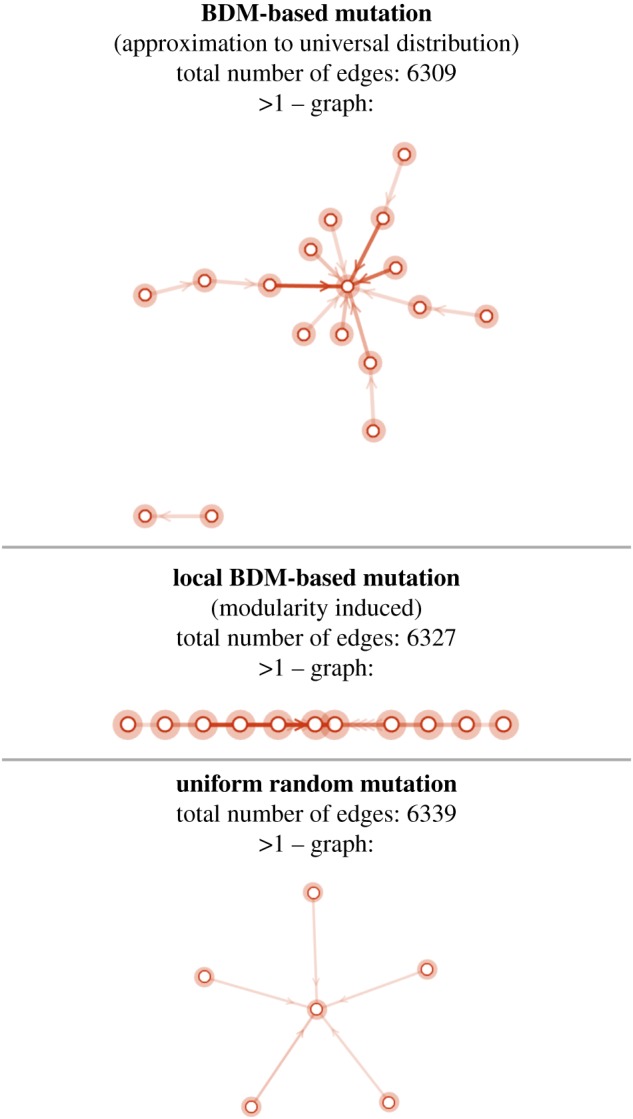
Evolutionary convergence in evolutionary subnetworks closest to the target matrix with edges shown only if they were used more than once. The darker the edge colour the more times that an evolutionary path was used to reach the target; the highest number is 7 for the BDM-based mutation (top) and the lower 2 (e.g. all those in the uniform random distribution). BDM-based is the only disconnected graph meaning that it produced a case of convergent evolution even before reaching the target.